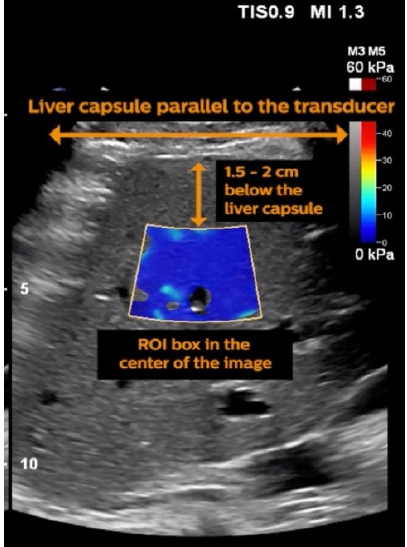
Figure 2. Example of results provided by 2D-SWE along with a 2D colour map and region of interest (ROI). The liver capsule is parallel to the transducer surface, and the ROI is positioned about 1.5–2 cm below the liver capsule. Adapted with permission from Philips Electronics Australia Limited [59].